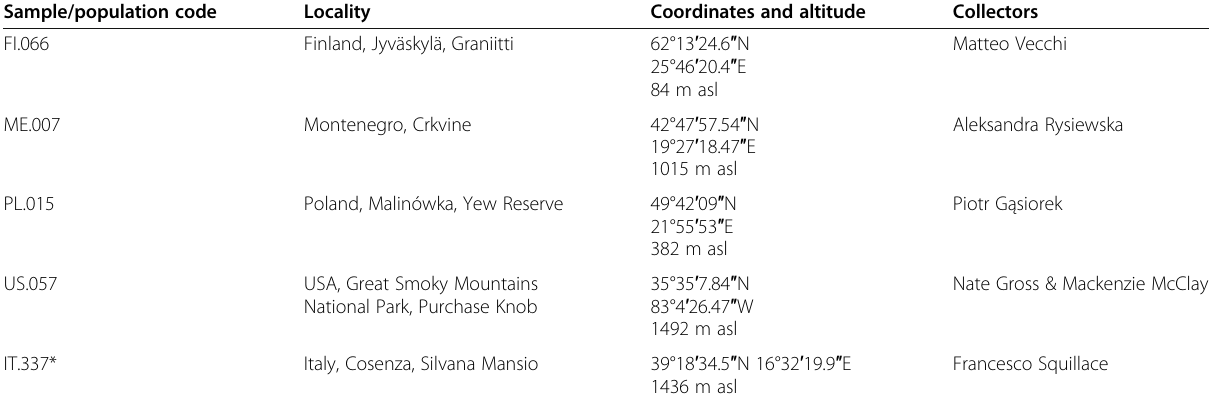
Table 1 Information on moss samples with the populations of the Macrobiotus pallarii complex analyzed in the present study. *Type locality of Macrobiotus pallarii